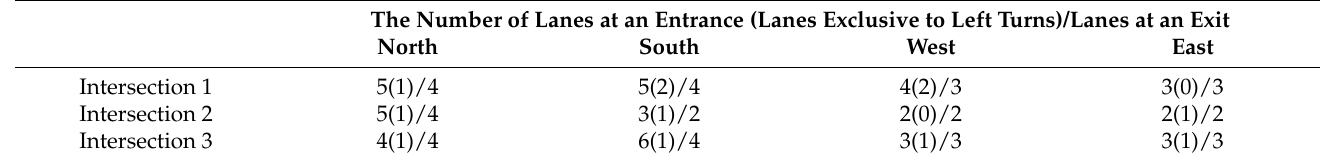
Table 1. Characteristics of the targeted intersections.